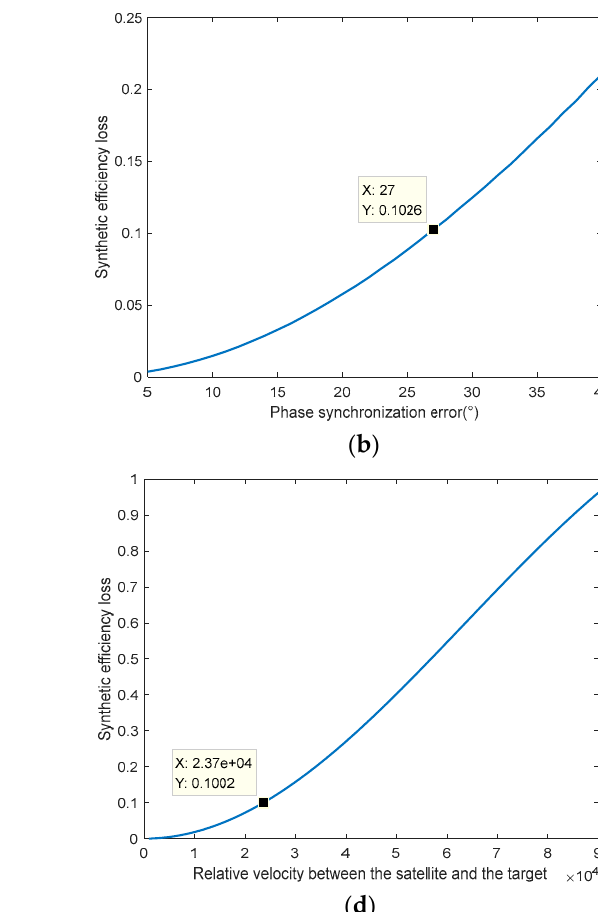
Figure 5. Target coherent integration efficiency map. ( a ) Target coherent integration efficiency under ideal conditions in the whole detection space; ( b ) target coherent integration efficiency with detection range constraints in the whole detection space.